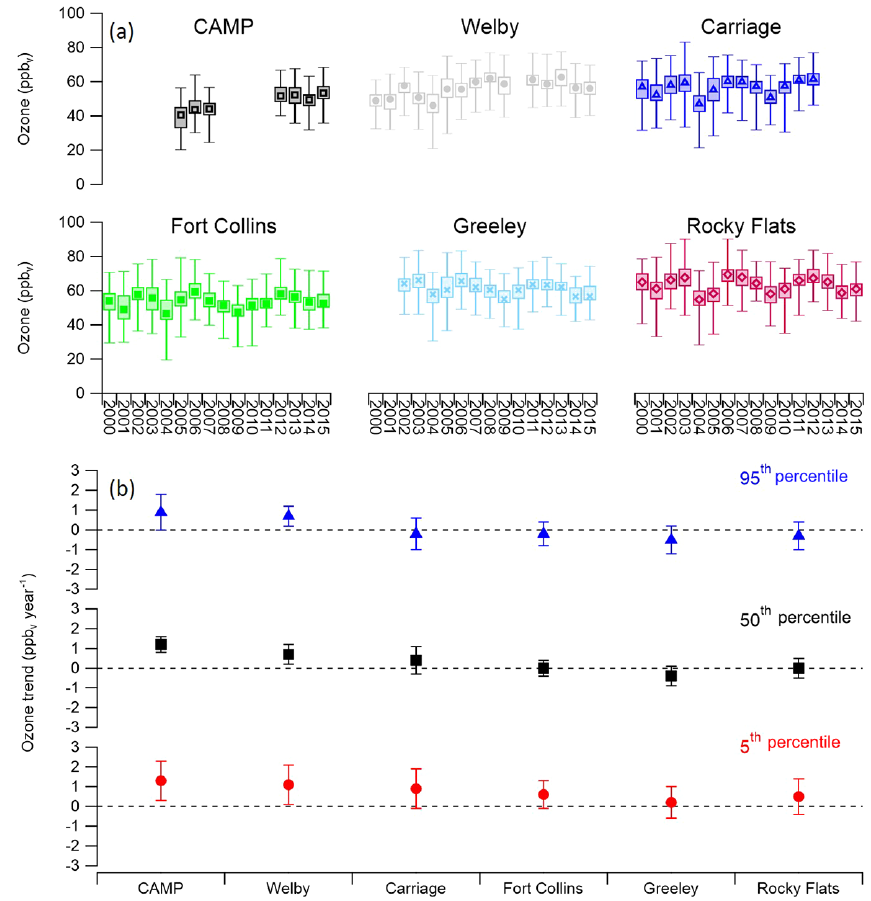
Figure 2. (a) Trends in summer (1 June–31 August) daytime (10:00–16:00LT) O 3 for six sites in the NFRMA between 2000 and 2015. Whiskers correspond to the 5th and 9th percentiles, box thresholds correspond to the 33rd and 67th percentiles, and the marker corresponds to the 50th percentile. Percentiles were calculated from daily daytime averages of hourly O 3 measurements at each site. The number of days used for each year’s statistics depended on available data ( n = 64–92). (b) O 3 temporal trends were determined as the slope from annual trends (ppbv O 3 yr − 1 ) from simple one-sided linear regression for the six NFRMA sites for the 95th (blue triangles), 50th (black squares), and 5th (red circles) percentiles. Error bars represent the 95% confidence interval around the ozone/year linear regression